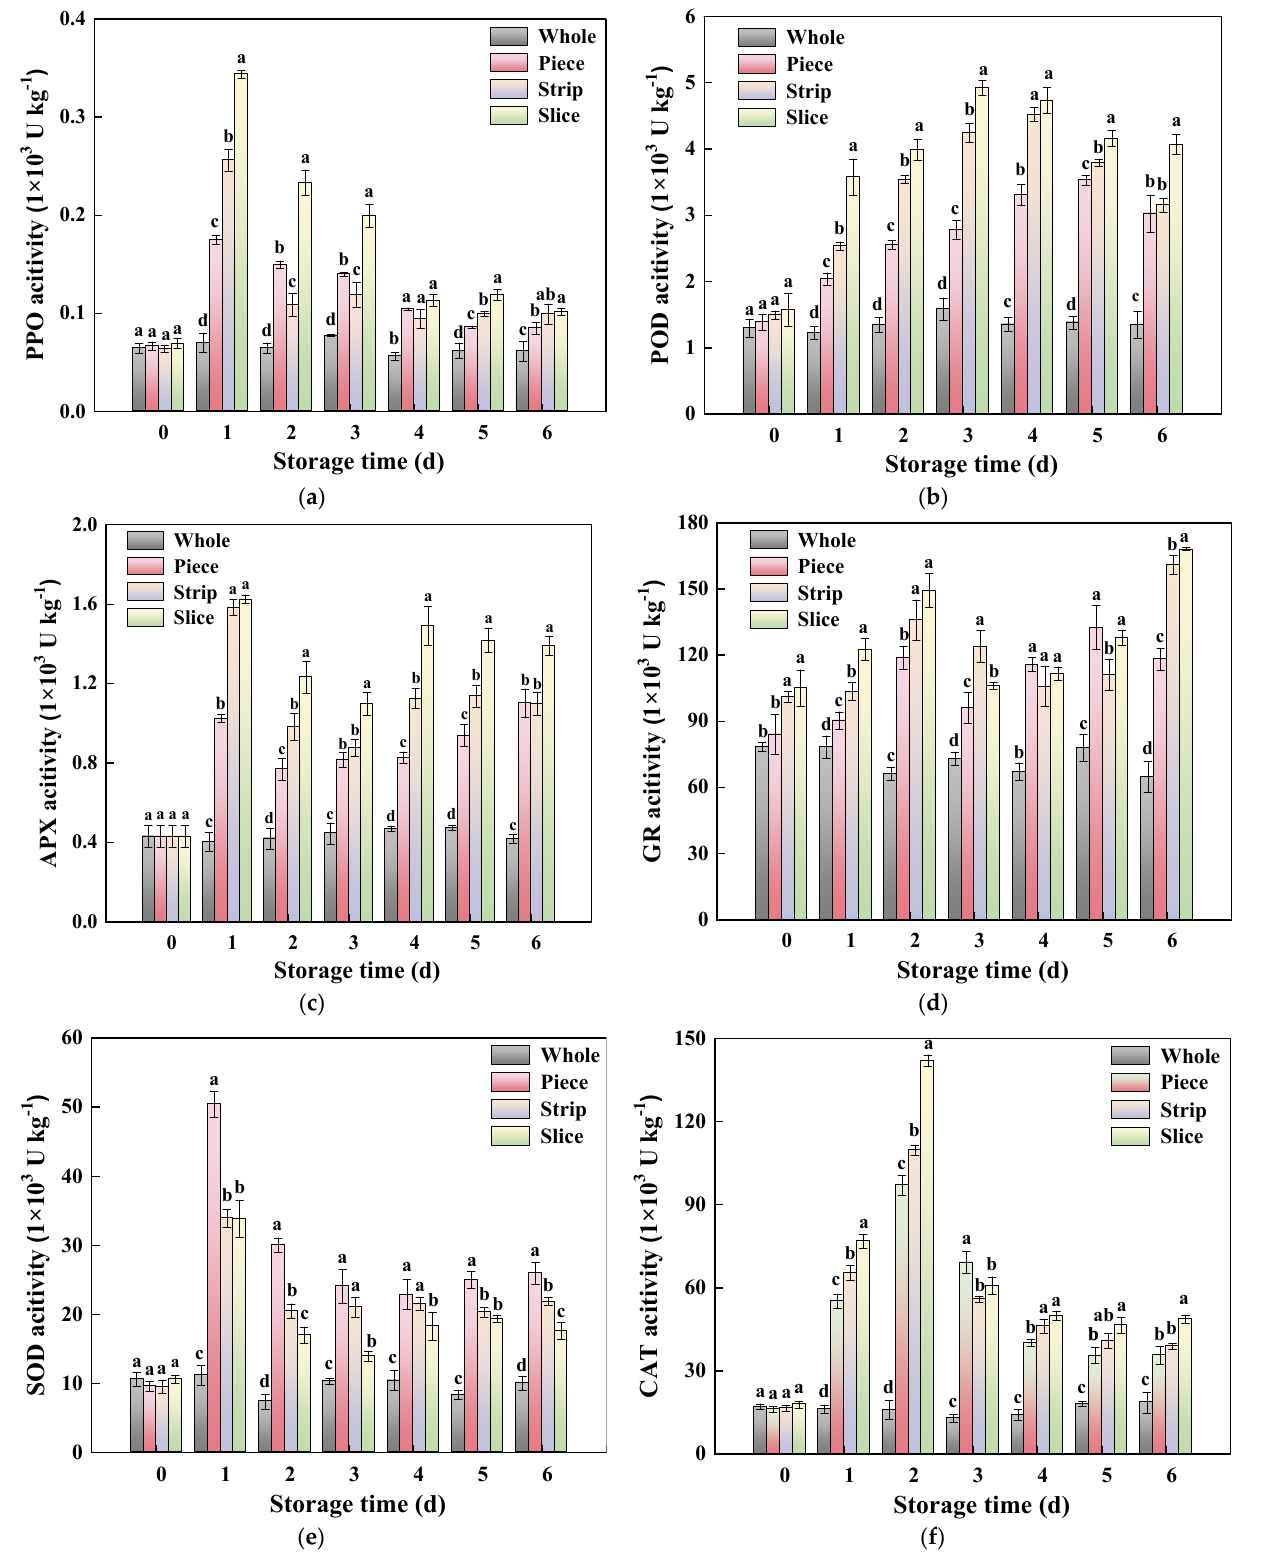
Figure 7. Effect of wounding intensities on PPO ( a ), POD ( b ), APX ( c ), GR ( d ), CAT ( e ) and SOD ( f ) activity of fresh-cut pumpkin during storage at 4 °C for 6 days. Vertical bars represent the standard deviation of the mean (n = 3). Different letters indicate significant differences between the groups ( p < 0.05).